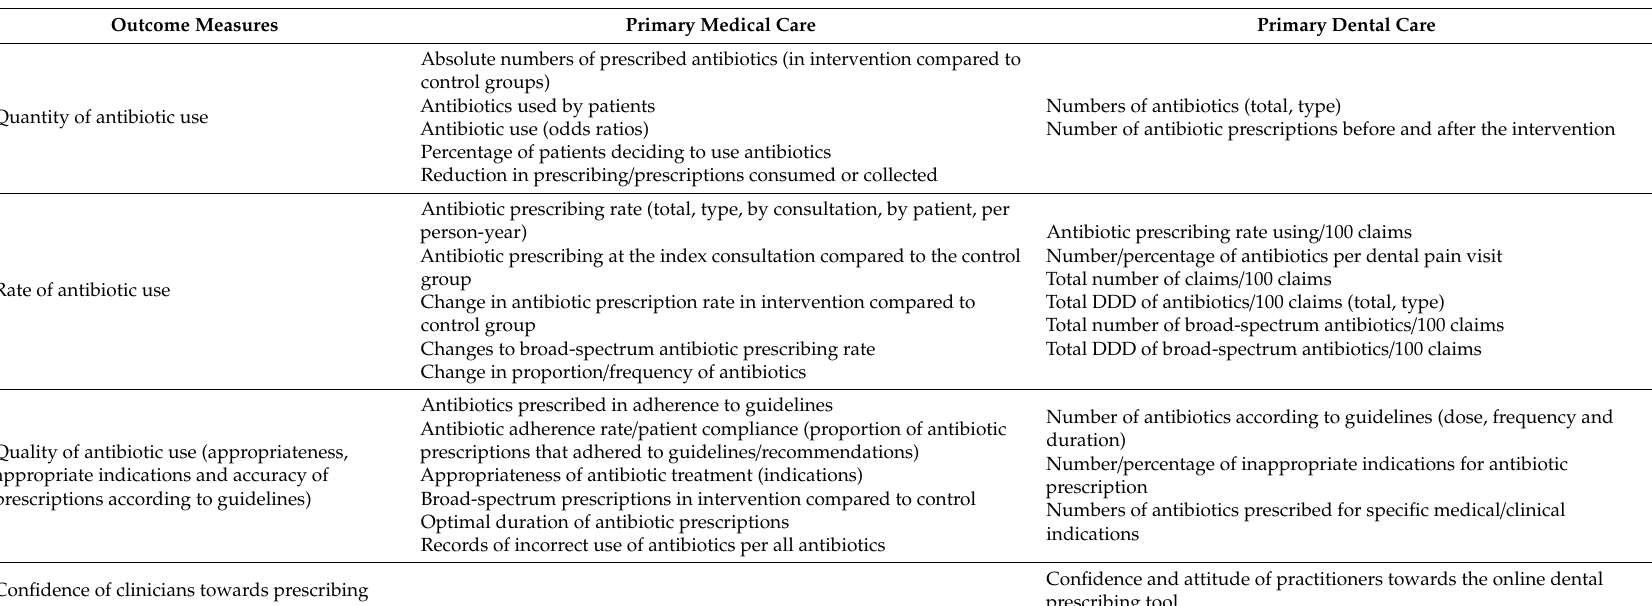
Table 3. Comparing outcomes between primary medical and dental care to